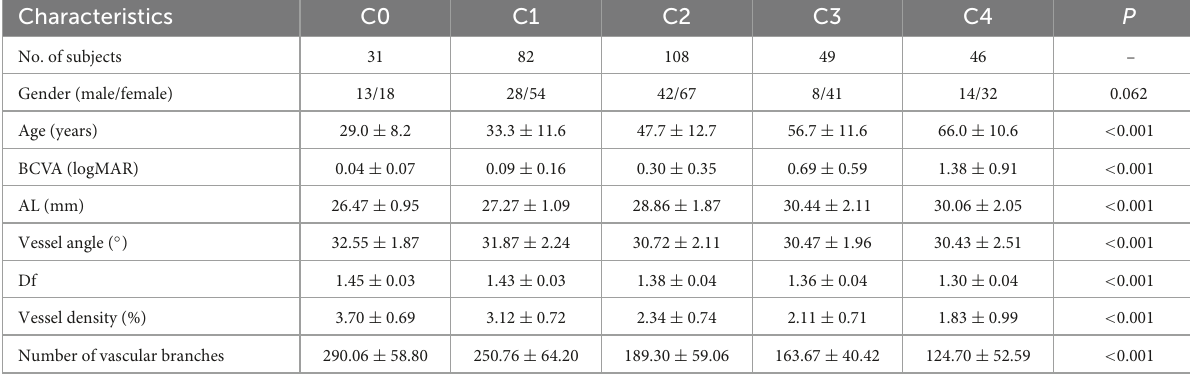
TABLE 1 Demographic, morphological, and vascular characteristics of the five HM group.